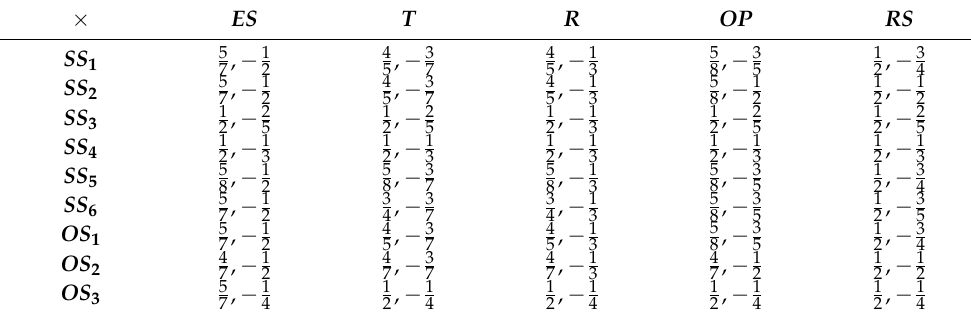
Table 6. Cartesian product S × A in a bipolar fuzzy